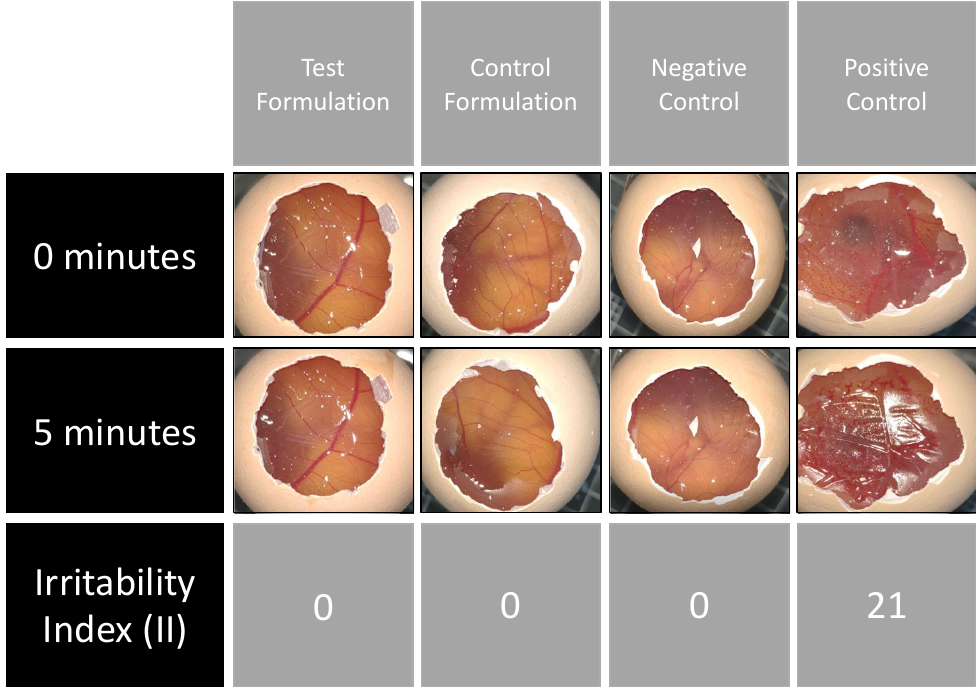
Figure 4. Irritability test (HET ‐ CAM) results, demonstrating the effect of positive (NaOH 1 M) and negative NaCl 0.9%) controls, test and control formulations on the chorioallantoic membrane with 0 min, 5 min, and the Irritability Index (II).